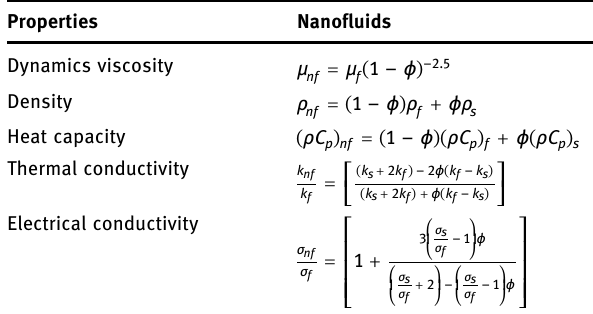
Table 1: Thermophysical features of second - grade nanoliquid